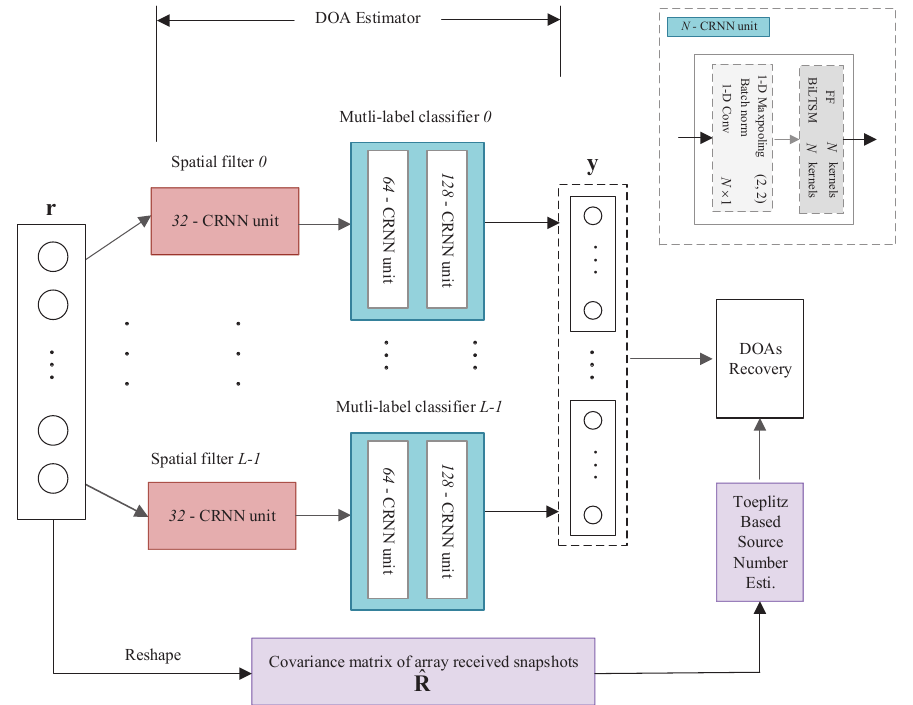
Figure 2. Framework of Toeplitz alternate convolutional-recurrent neural network (A-CRNN)-based coherent direction-of-arrival (DOA) estimation without knowing the source